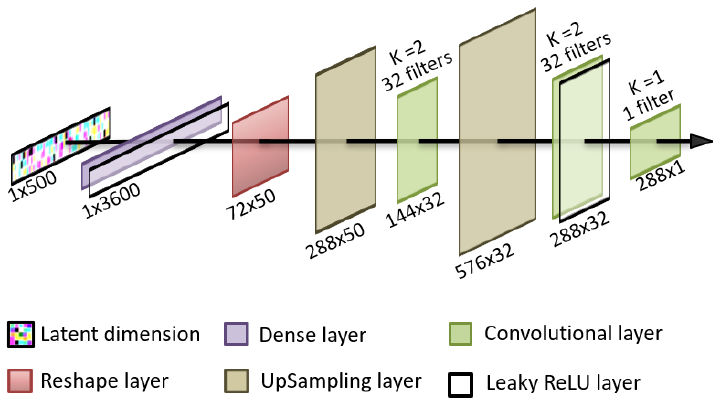
Figure 1. Graphical representation of the generator architecture.